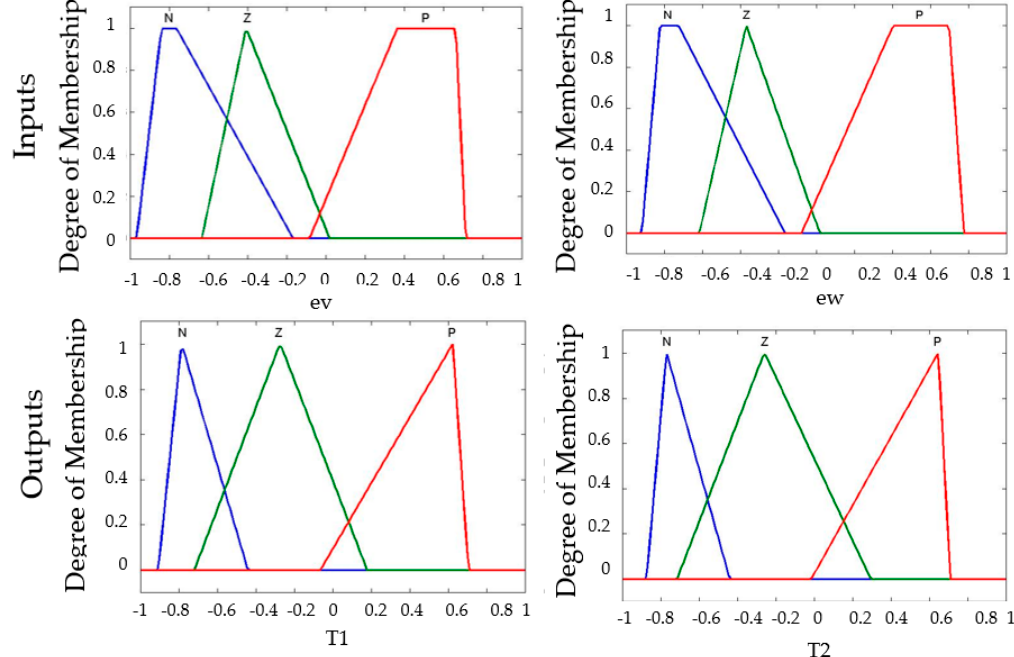
Figure 22. Best Distribution of membership function found by FBCO with Generalized Type-2 FLS.